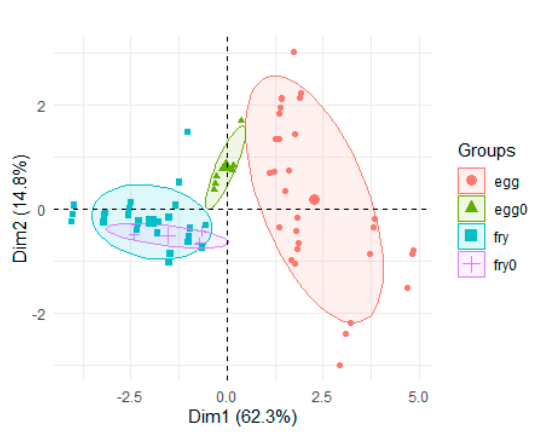
Figure 3. PCA by groups according to the life stage (eggs, fry) of the rainbow trout, chemical compound (CuNPs, CuSO 4 ), and Cu concentration (0, 1, 2, 4, 8, 16 mg/L).